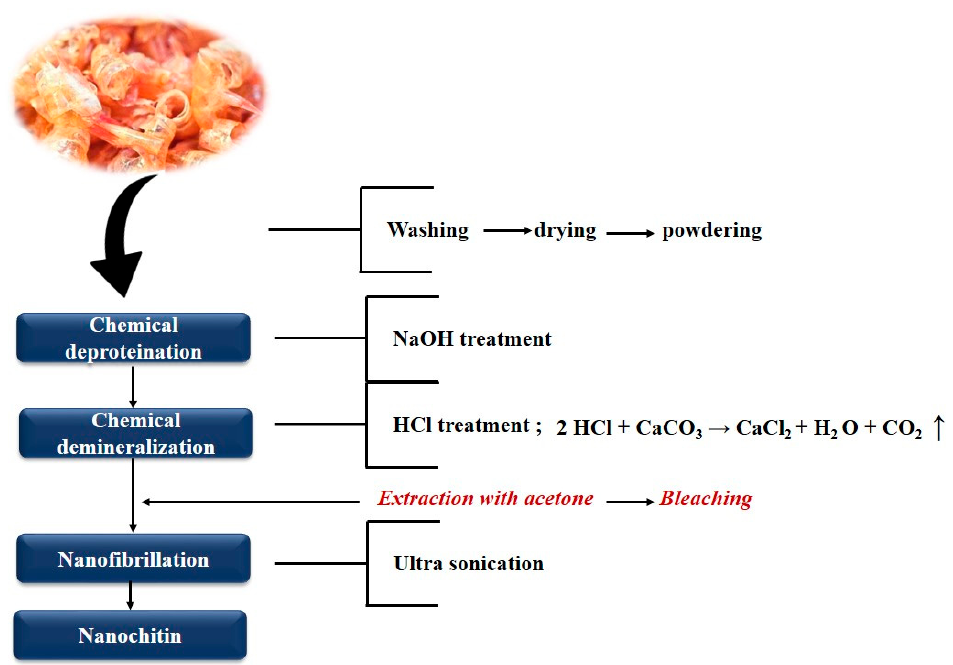
Figure 3. General protocol for extracting chitin nanofibers from prawn shells by using ultra- sonication.